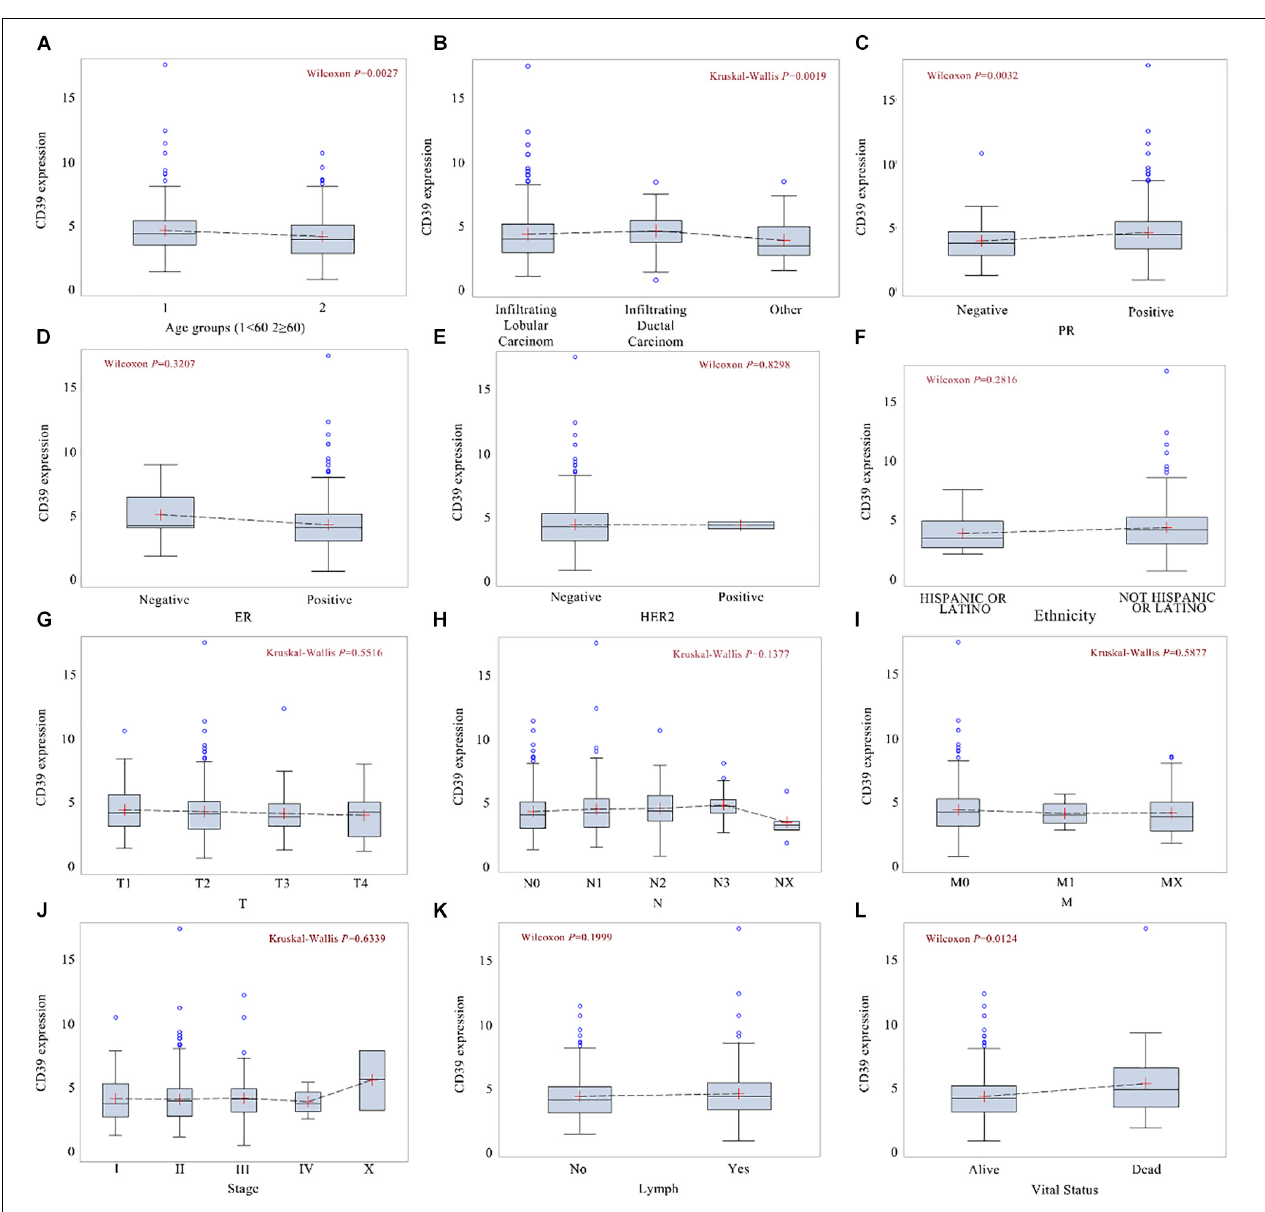
FIGURE 2 | Differences in CD39 expression were shown in boxplots according to patient age (A) , histological type (B) , PR (C) , ER (D) , HER-2 (E) , molecular subtype (F) , T classification (G) , N classification (H) , M classification (I) clinical stage (J) , lymph node status (K) , and vital status (L) .